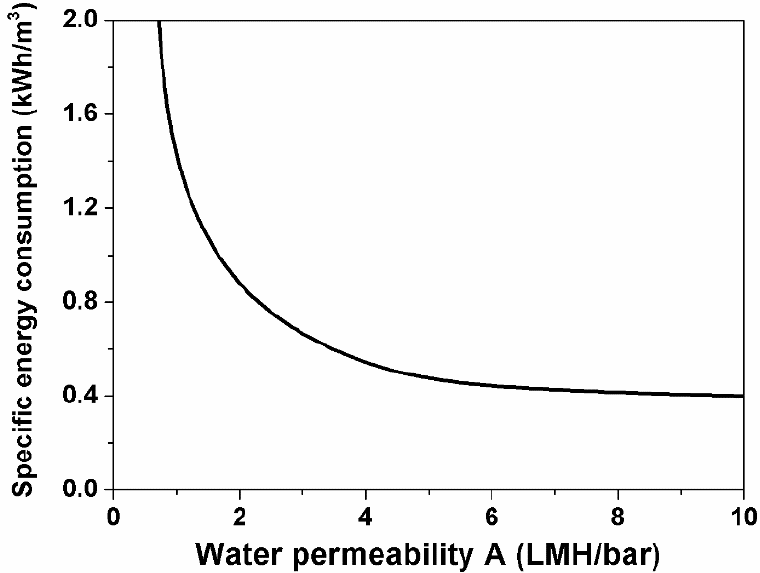
Figure 3. The specific energy consumption (SEC) as a function of membrane permeability. The SEC was plotted based on the data for BWRO summarized from Cohen-Tanugi et al. [39]. BWRO is modeled with a 2000 ppm NaCl feed solution at 65% recovery.